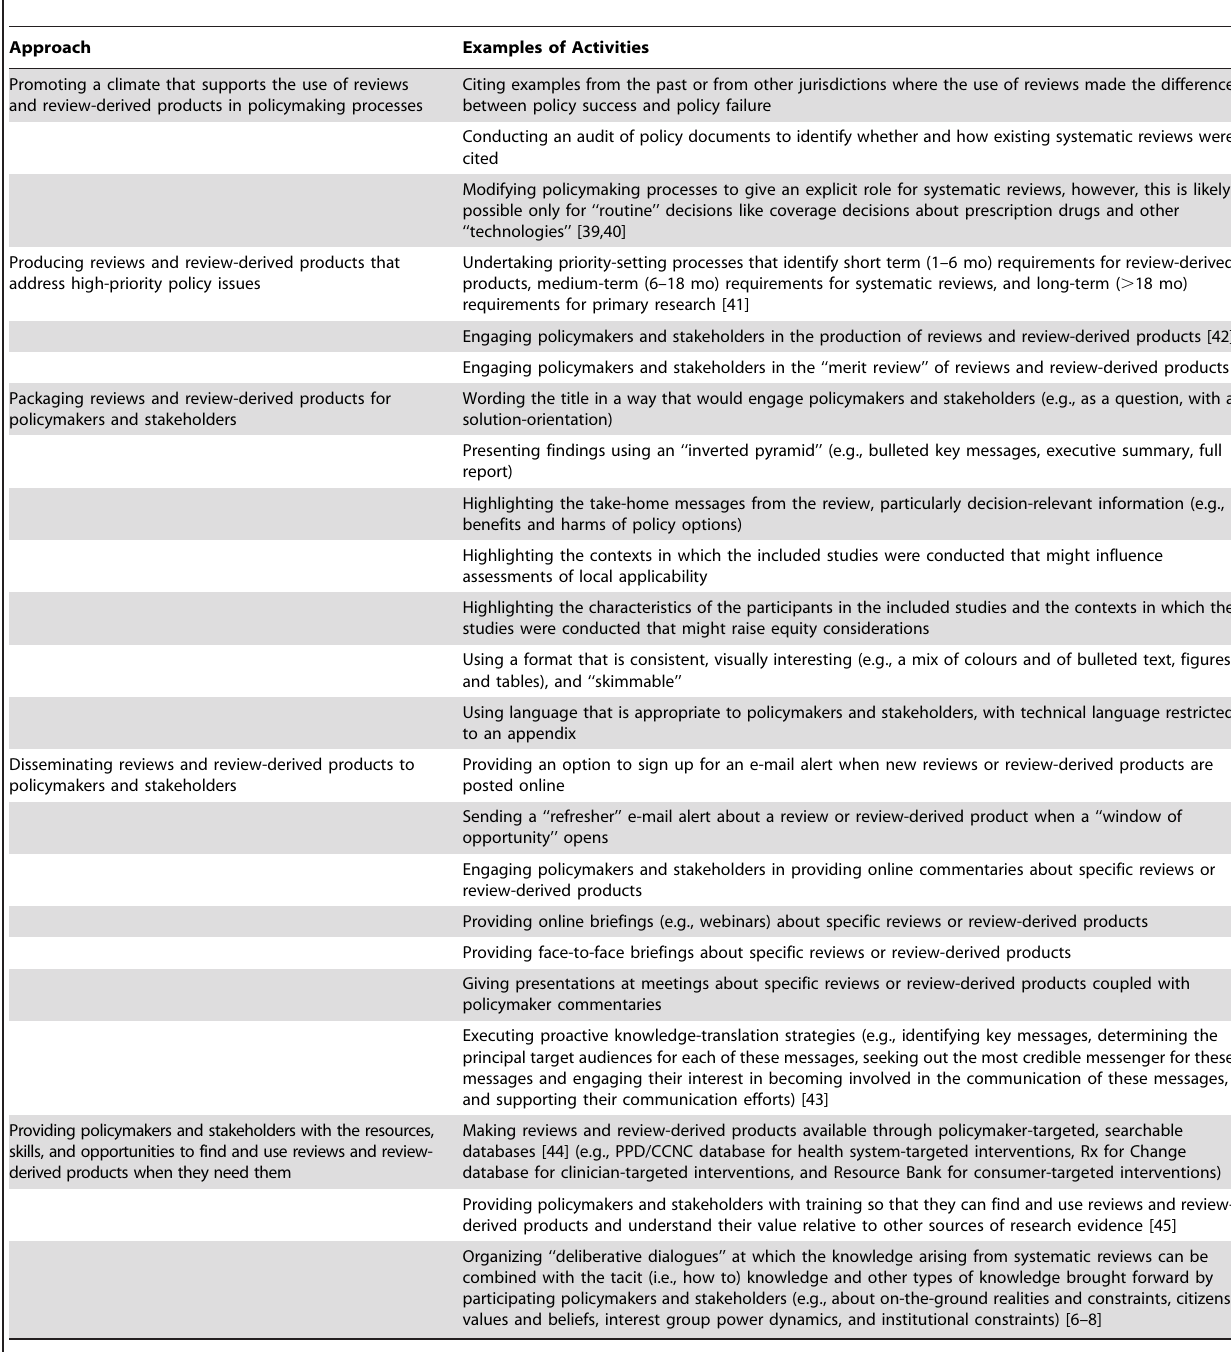
Table 3. Examples of activities to support the use of systematic reviews and review-derived products by policymakers and